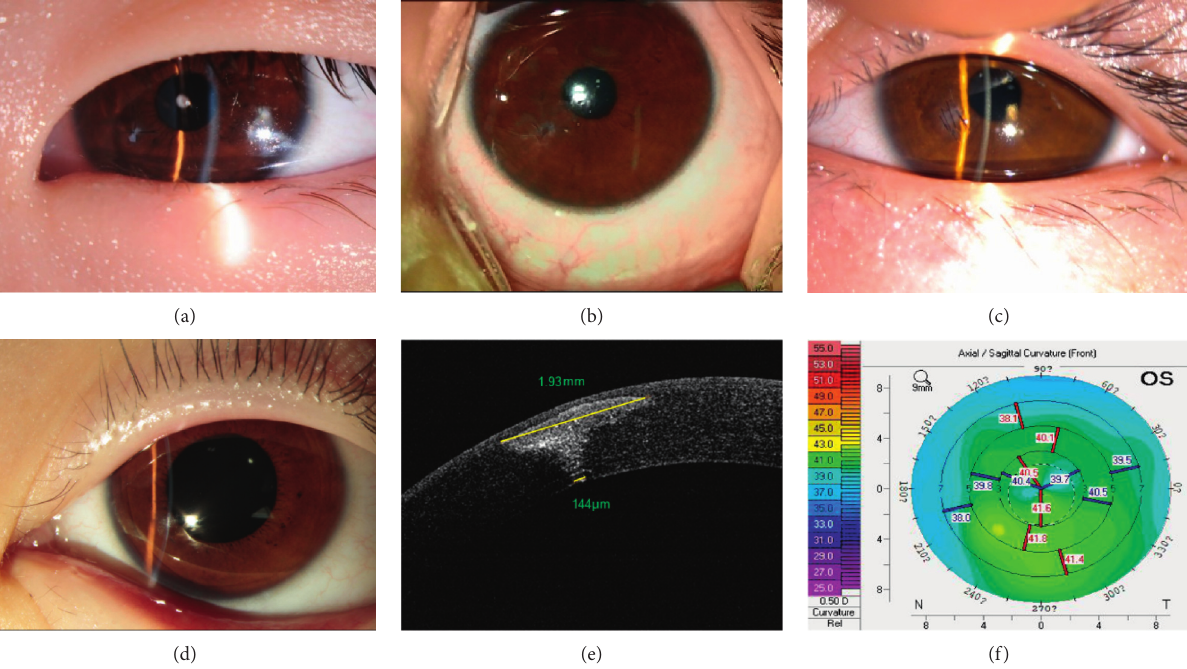
Figure 4: Penetrating corneal patching with an irregular wedge-shaped patch for pencil pricking. (a) The sutured cornea is packed with the amniotic membrane in the wound, with secretions accumulating on the central cornea, and the UCVA is 1.0 log MAR. (b) Morphology of tissue defects after removing the sutures and amniotic membrane. (c) A photograph at 1 week after surgery. (d–f) Examination at 4 years after surgery. (d) The graft opacity is decreased, and the UCVA is 0.1 logMAR. (e) AS-OCTshows that the longitudinal of the anterior surface of the patch is 1.93 mm, while the width of the posterior surface is 144 μ m. (f) The curvature of the front cornea is